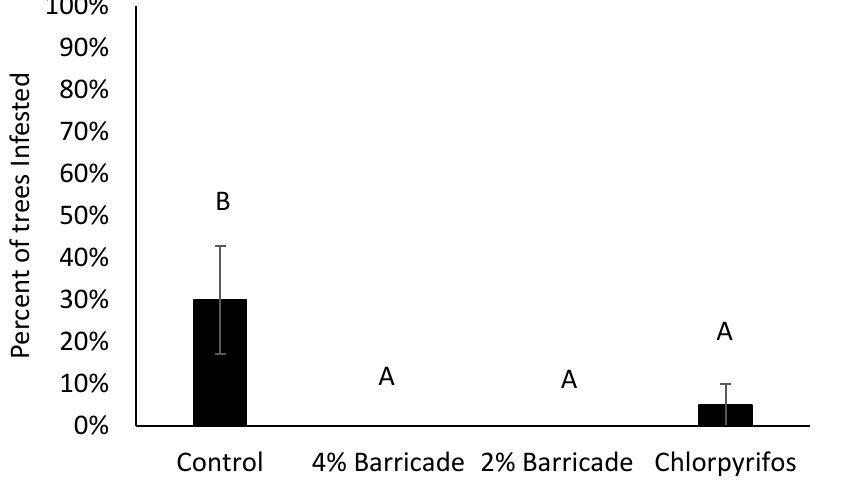
Figure 5. Percentage of peach trees infested with peachtree borers, comparing rates of Barricade ®